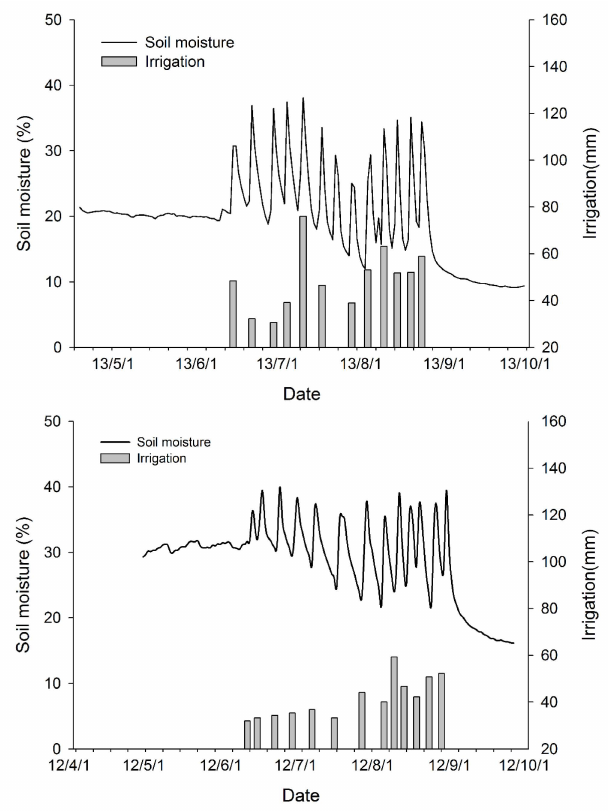
Figure 7. Daily variation of soil moisture under irrigation for cotton in